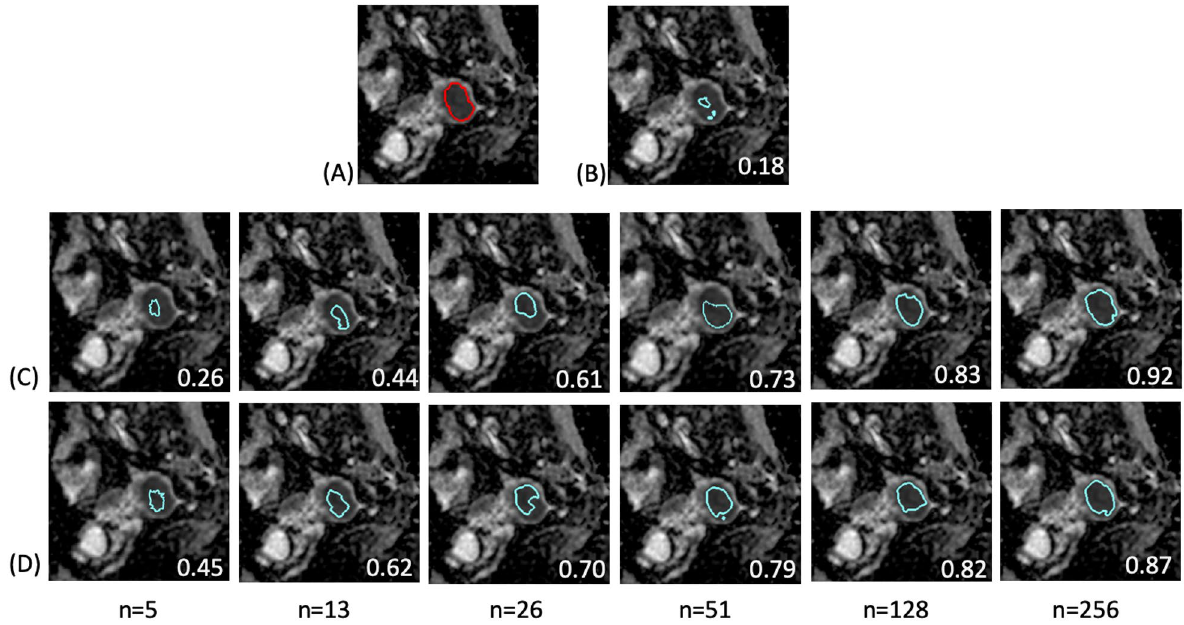
Fig. 4 Demonstration of predicted tumor contours in a patient with endometrial cancer using various training combinations and sample sizes on the uterine dataset. A The tumor contour was delineated manually (red contour) and overlaid on the ADC image. The blue contours delineate the automatically generated tumor regions by using: B pretrained cervical model; C uterine‑only model; D TL model with fine‑tuned at L1 level. The numbers in white at the right bottom of each image indicate the DSC of the case. The pretrained cervical model itself generated only a small part of the tumor with DSC 0.18. The accuracy increased as more uterine data were added for fine‑tuning. The TL model outperformed the uterine‑only = model when the fine‑tuned data size was < 128. The uterine‑only model exhibited the highest DSC of 0.92 when all patient data were